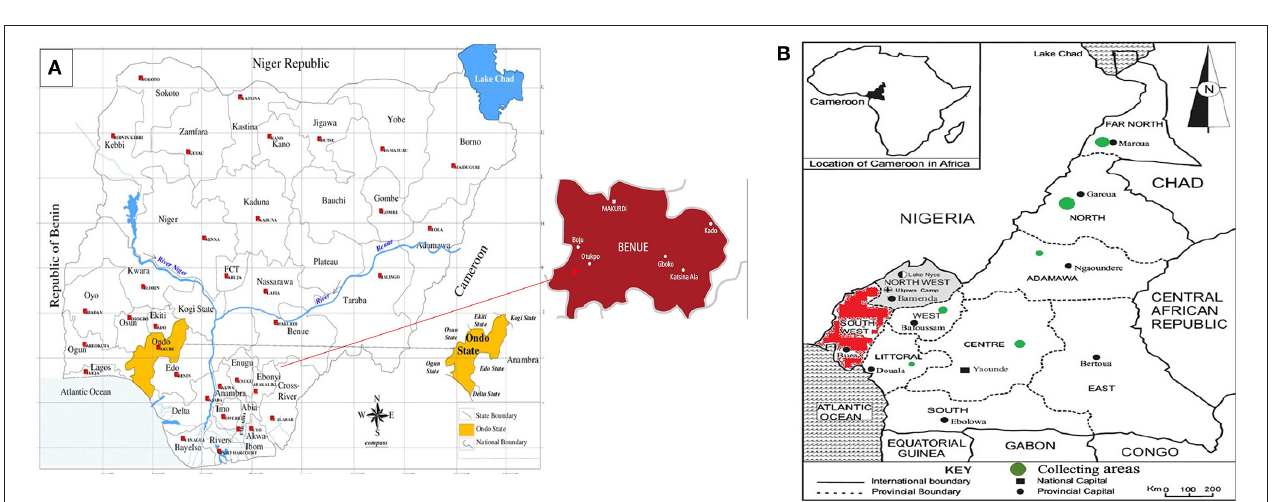
FIGURE 4 | Germplasm collection collected in year 2019 for African orphan legumes; (A) Map of geographic locations in Nigeria showing Ondo and Benue state where Kersting’s groundnut germplasm were collected, (B) map of geographic locations in Cameroon where Bambara groundnut germplasm collected (The map is adapted from Henry and Roger, 2012). The collecting areas of Bambara groundnut are shown in green circles in the